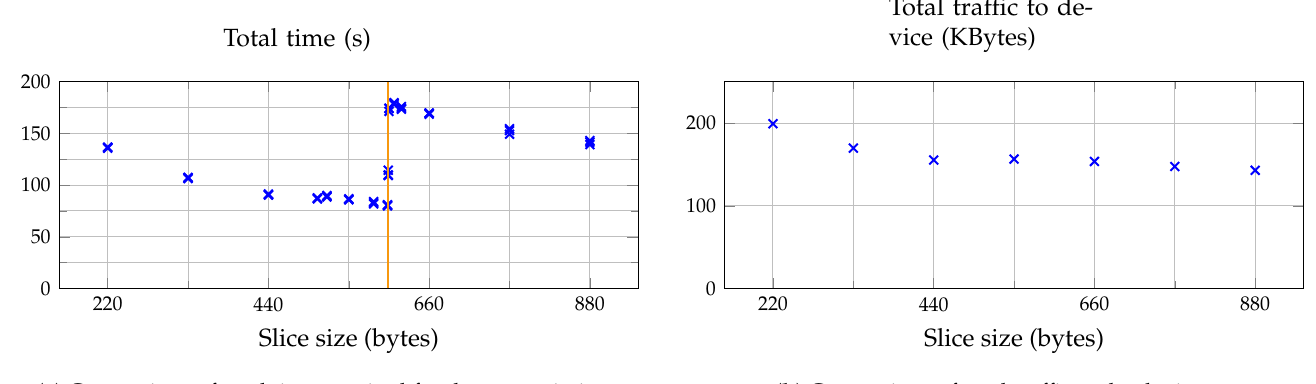
Figure 6. Comparison of different slice sizes. The updates were transmitted in binary encoding, using MQTT ACKs and a response topic